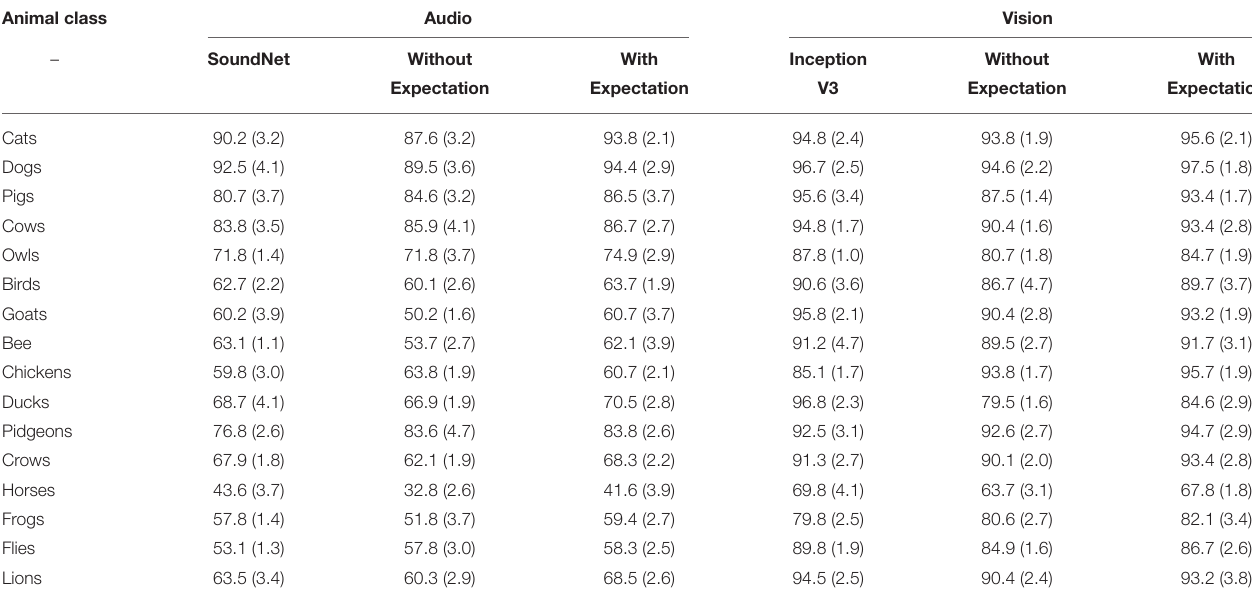
TABLE 5 | Mean accuracy, in percentage, and standard deviation of our experiments per classification